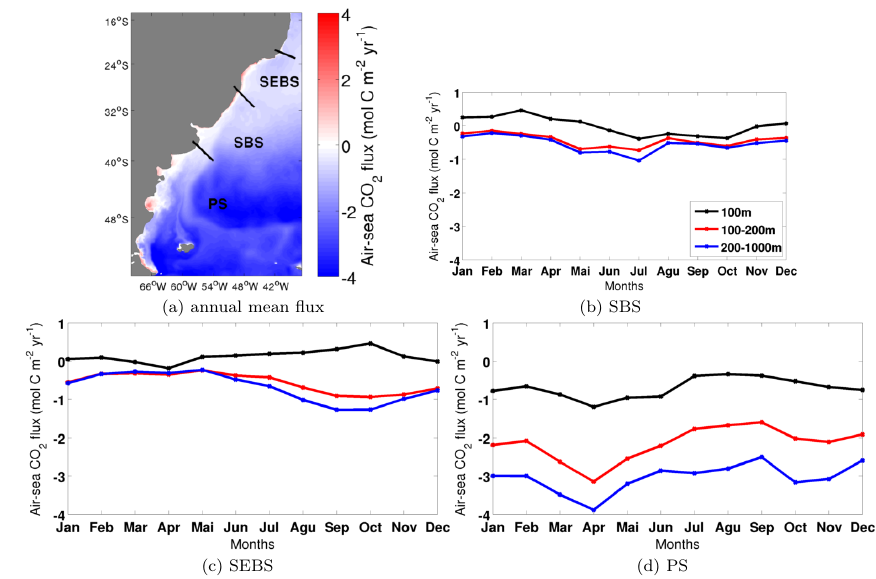
Figure 12. Panel (a) is the annual mean of air-sea CO 2 fluxes. Panels (b) , (c) and (d) show the monthly average of surface CO 2 fluxes constrained to bathymetry levels of 100, 200 and